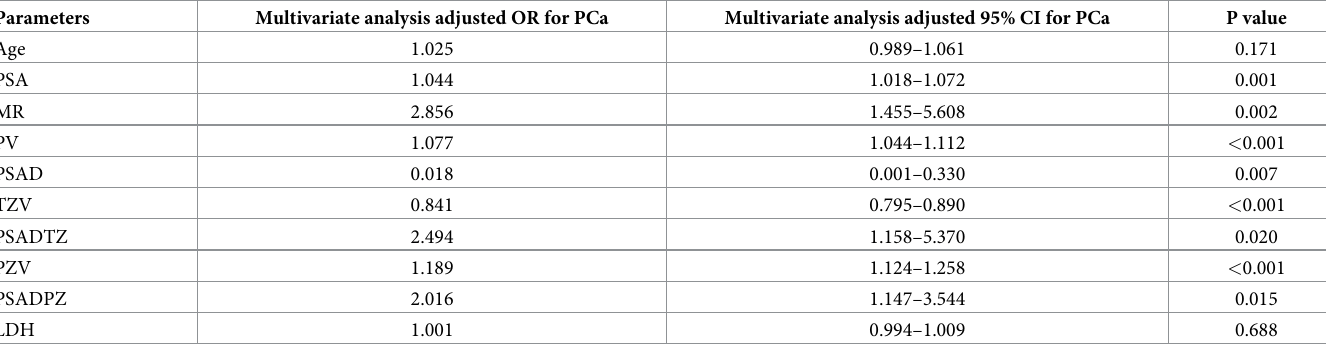
Table 3. Multivariate logistic regression analysis of predictors associated with PCa at the initial biopsy. Parameters